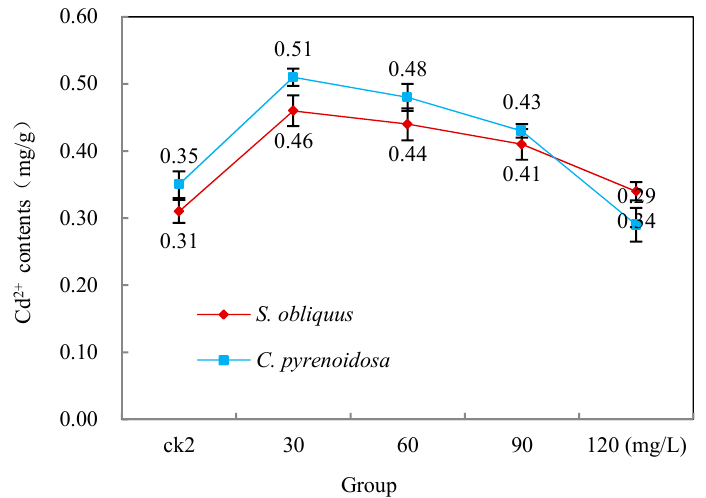
Figure 5. Effects of salicylic acid on the Cd 2+ uptake of S. obliquus and C. pyrenoidosa after 96 h.